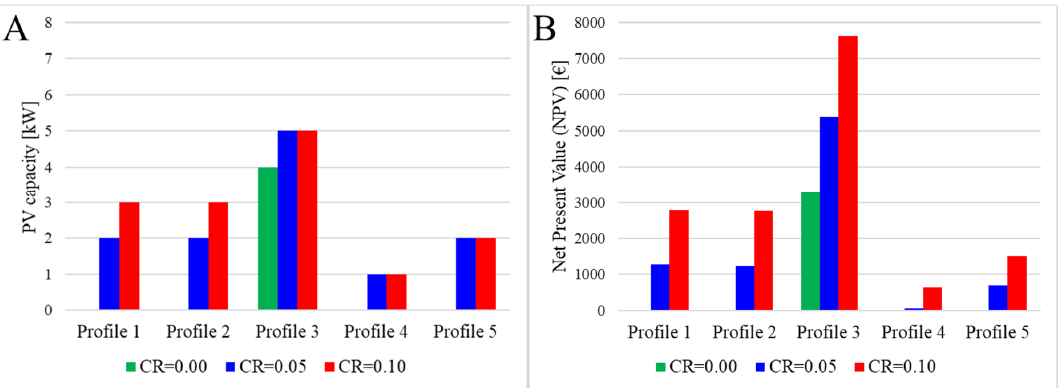
Figure 5. PV size ( A ) and NPV ( B ) in Seville, maximum profitability for different compensation rates (CRs, EUR/kWh).